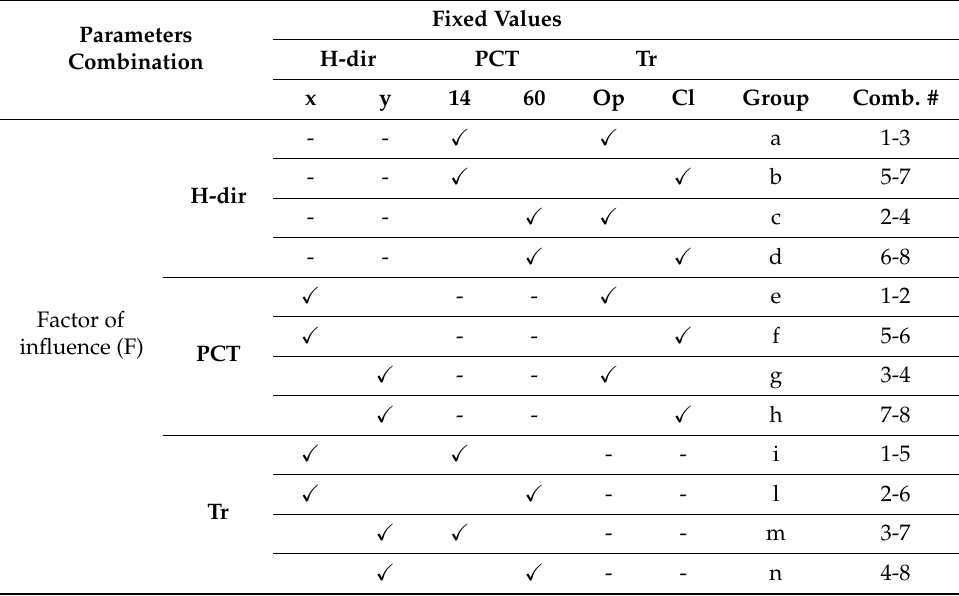
Table 3. Sample groups for